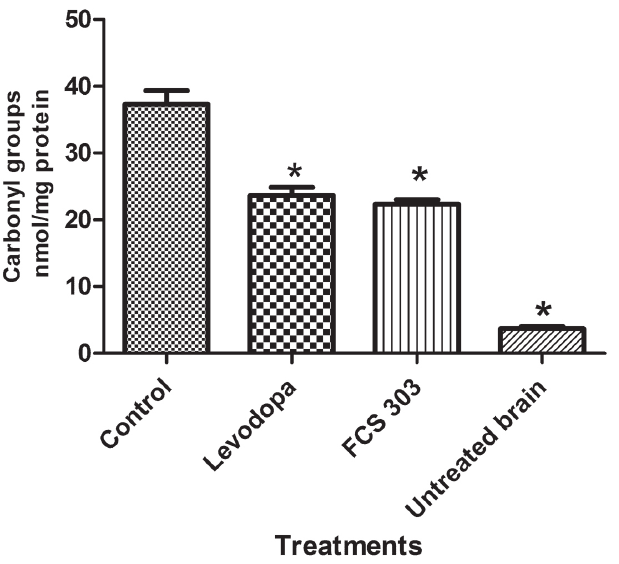
FIGURE 7 - Effect of administration of FCS303 (50 mg/kg), control (vehicle 0.1 mL/10 g body weight), or levodopa/ carbidopa (400/40 mg/kg) on the oxidation of carbonyl groups of proteins in brain homogenates of mice treated with haloperidol (1 mg/kg) for 10 days. n = 8 mice. *p < 0.05 compared to the control